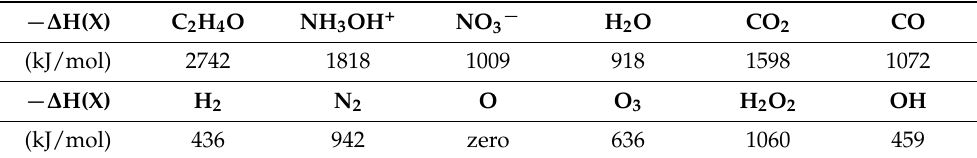
Table 1. Heat contents, − ∆ H(X), of the oxidizing agents and the products of combustion, generic designation, “X”, when formed from isolated atoms of the chemical elements. The heat content of atomic oxygen is zero, ∆ H(O) =